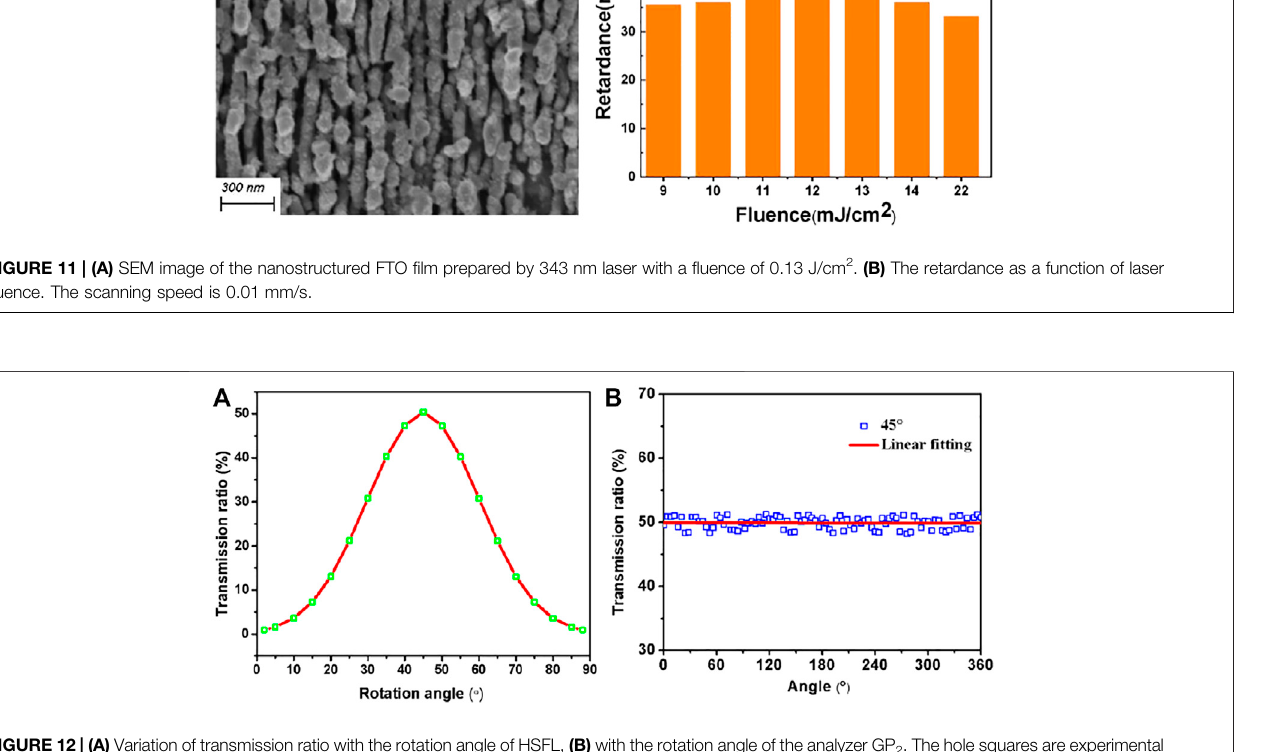
Frontiers in Physics |